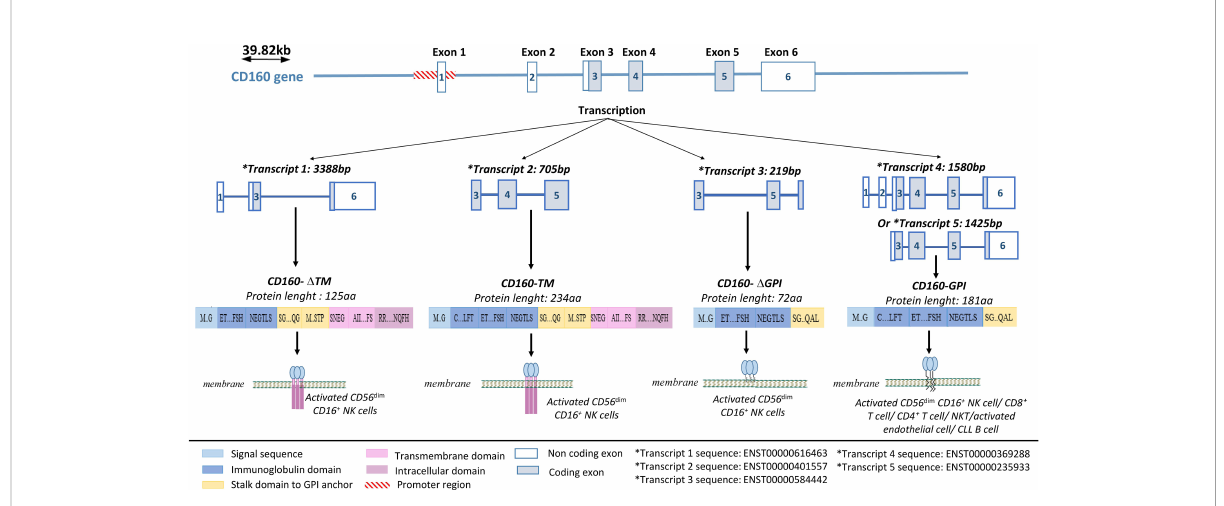
FIGURE 1 CD160 gene structure and isoforms. CD160 has four isoforms: a transmembrane isoform (CD160-TM), a glycophosphatidylinositol-anchored isoform (CD160-GPI), and two truncated isoforms (CD160- D Ig-GPI and CD160- D Ig-TM) that are generated through alternative splicing. Adapted from (57) and analyzed on